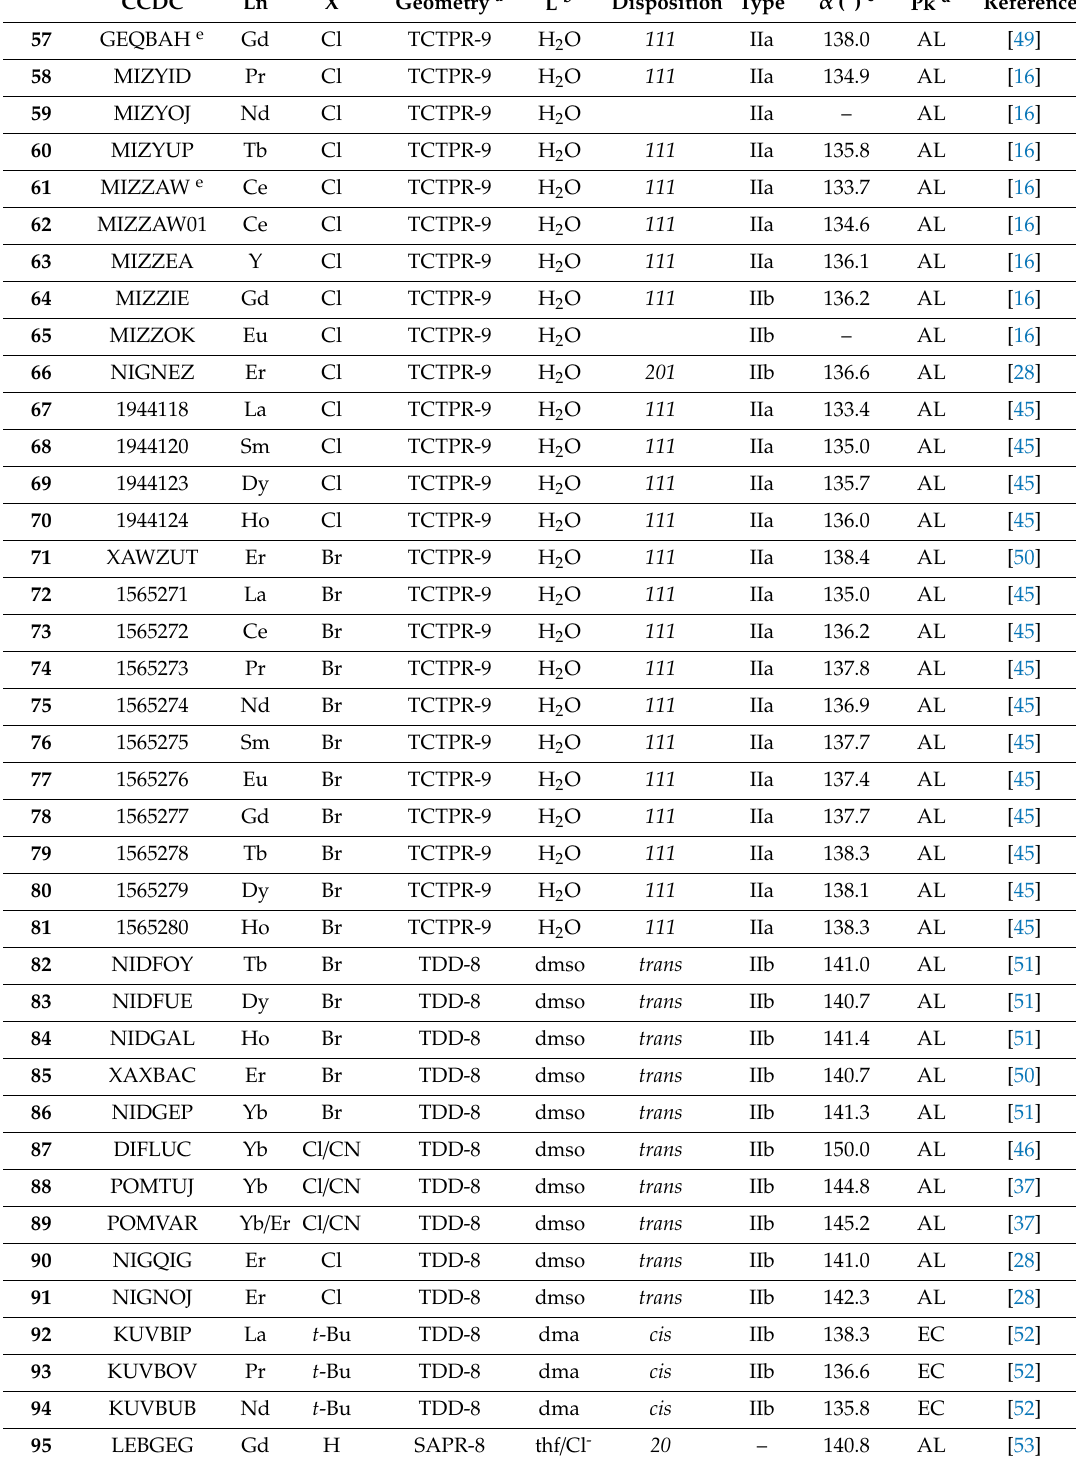
Table 3. Reported Ln-anilato compounds with distorted hexagonal 2D